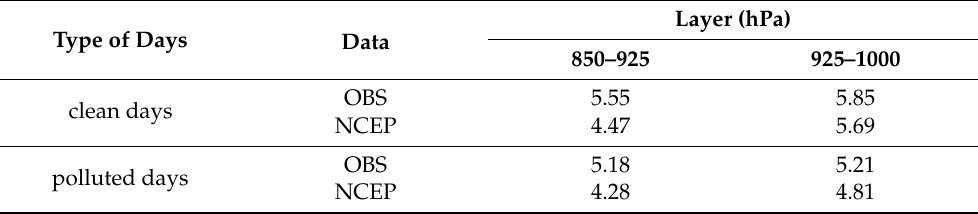
Table 7. Statistics for the wind shears between the observations and the NCEP/FNL reanalysis data during the clean days and polluted days (units: